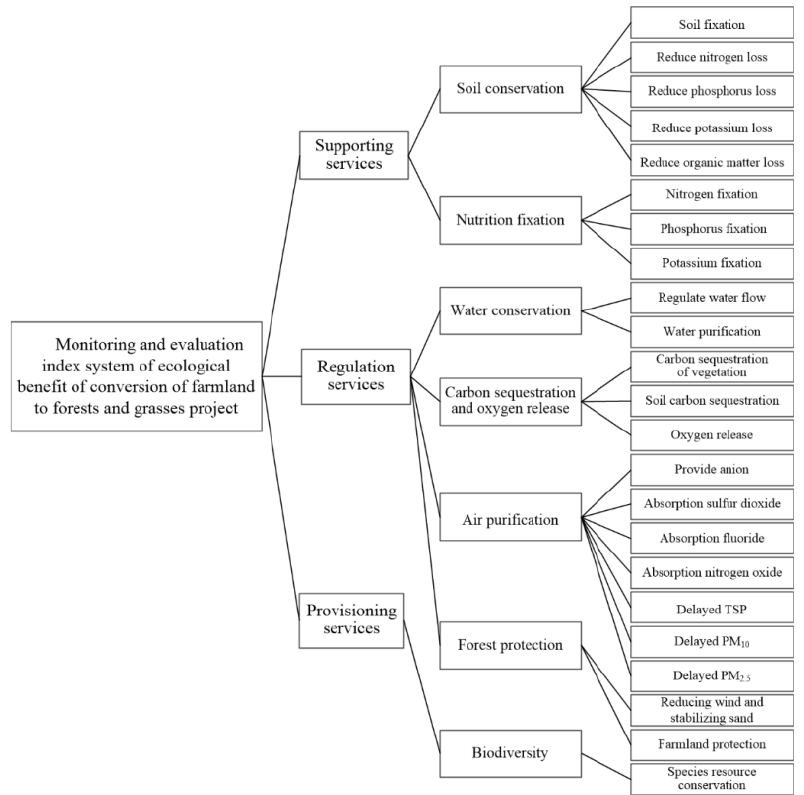
Figure 1. Monitoring and evaluation index system of ecological benefit of the CFFG project.